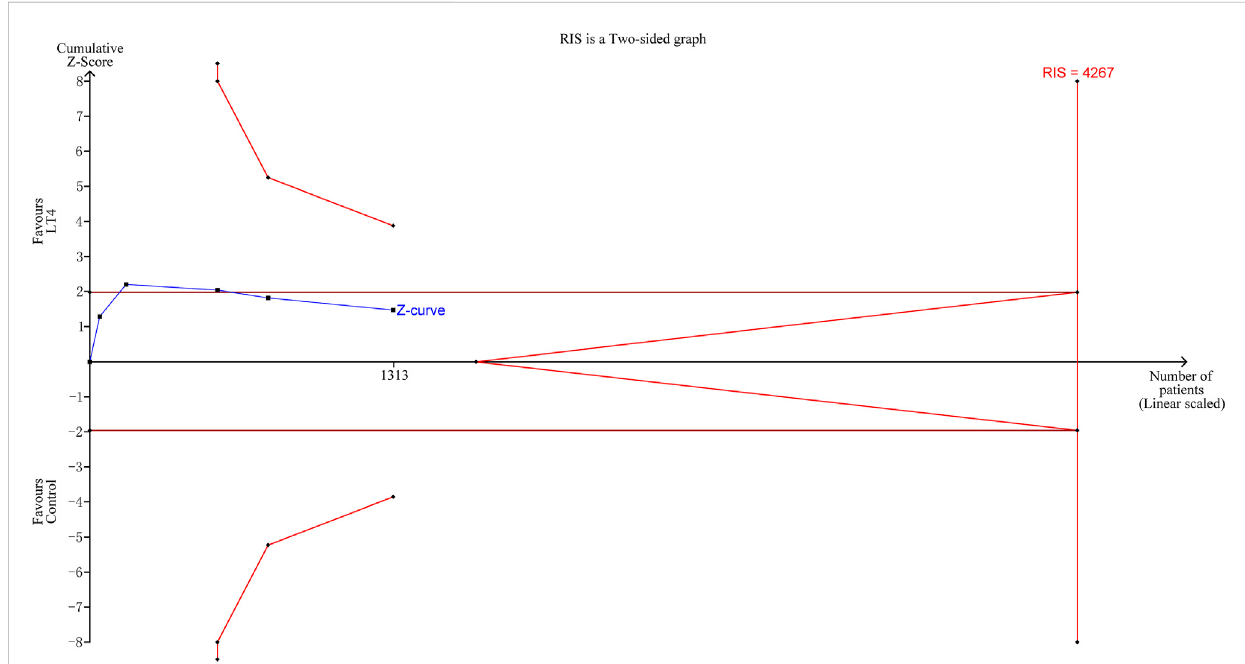
FIGURE 2 Trialsequentialanalysisofmiscarriage.TheriskoftypeIerrorwassetat5%withapowerof80%.Therelativeriskreduction(RRR)wassetat20%.The variance was calculated from the data obtained from the included trials.